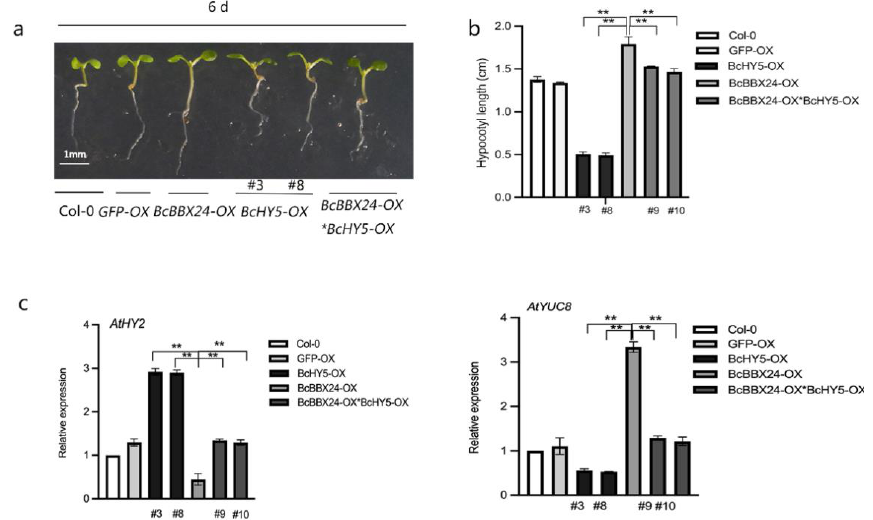
Figure 5. The BcHY5 * BcBBX24 -overexpression in Arabidopsis. ( a , b ) Hypocotyl phenotypes and length of Col-0, BcBBX24-OX , and BcBBX24-OX * BcHY5-OX transgenic lines of 6-day-old seedlings. ( c ) The analysis of genes’ relative expression level related to hypocotyl length of 6-day-old seedlings. The unit of hypocotyl length is millimeters. Asterisks (** p < 0.01, Student’s t -test) indicate statistical significance.